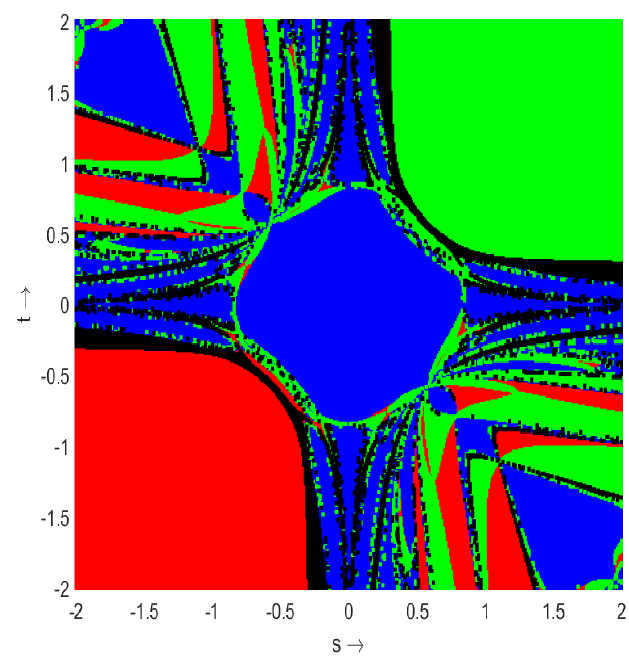
Figure 2. Dynamics of the method (3) associated with BA of Example 4.